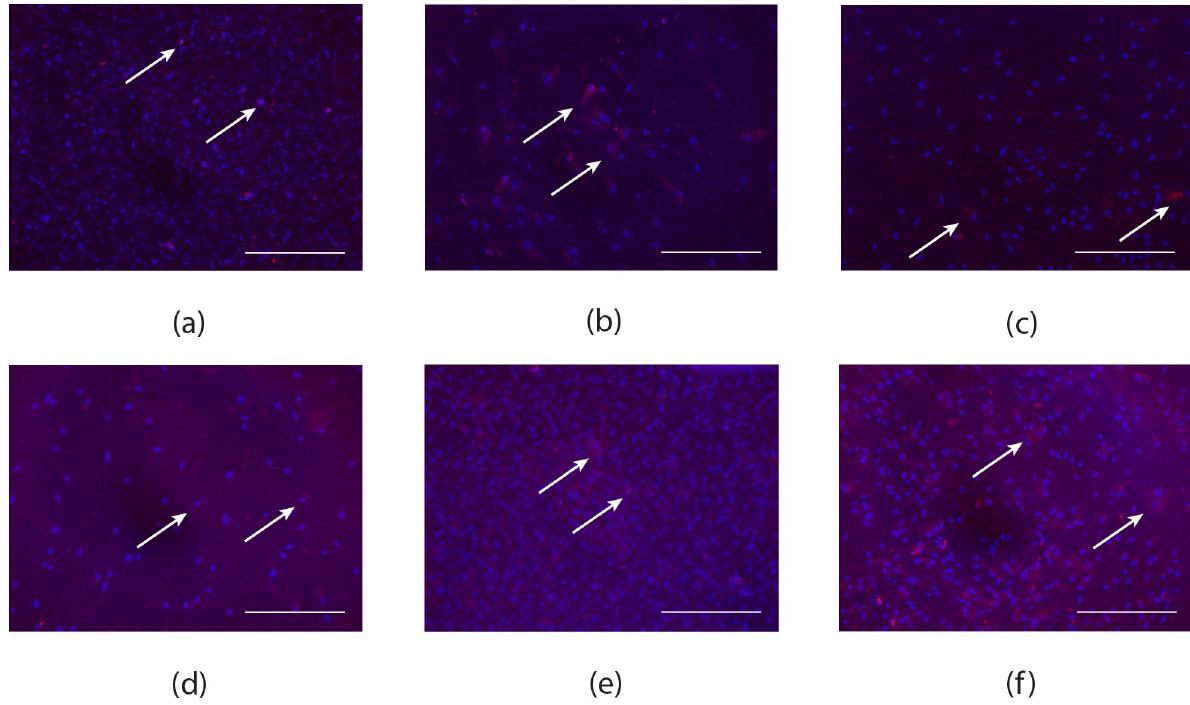
Fig 1. Representative immunofluorescence images of neonatal and patient-derived iECs. CD31 (red) immunofluorescence for (a) HCAECs, (b) neonatal-derived iECs; (c) Patient 1; (d) Patient 2; (e) Patient 3; (f) Patient 4, with cell nuclei stained purple using DAPI. Scale bars are 500 μ m.